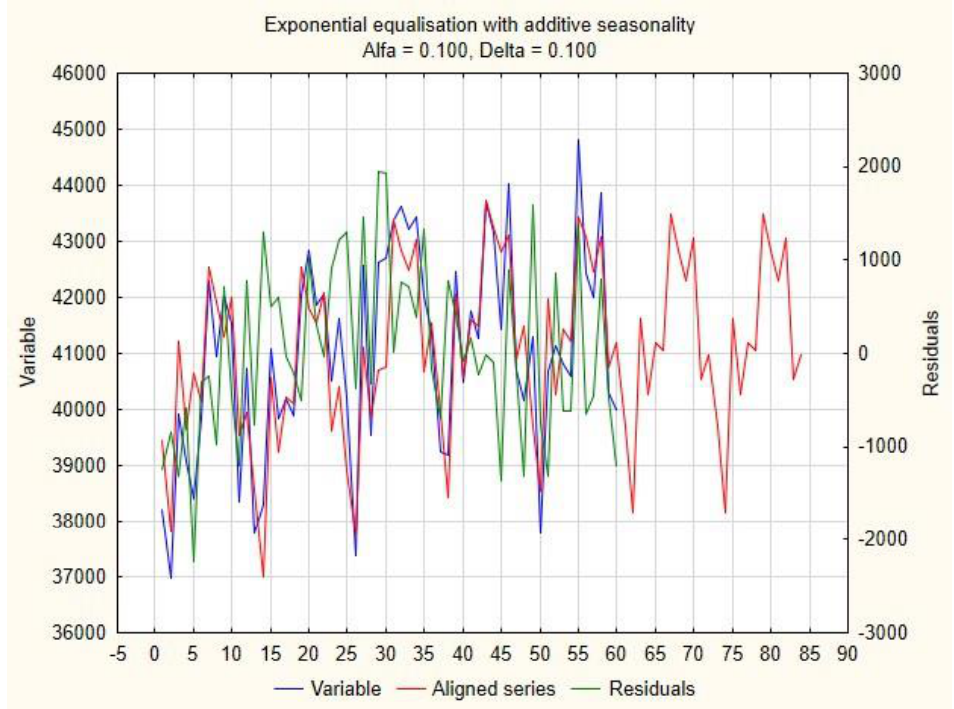
Figure 12. Exponential smoothing of supply volumes of oil products. Source: own elaboration. The values of the forecasts obtained on the basis of this are presented in Table 7, and the forecast errors are in Table 8. Table 7. Forecasts of the volume of oil products supplies on a monthly basis for 2020 – 2021 (in thousand tonnes). Source: own elaboration. Period